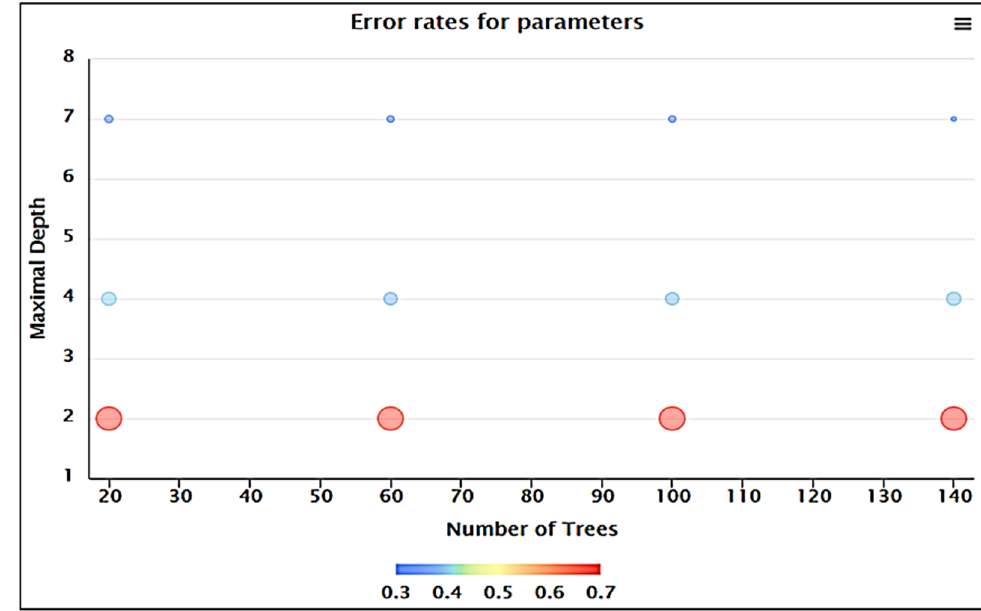
Figure 2. 3D optimization process of RF models with error rates.